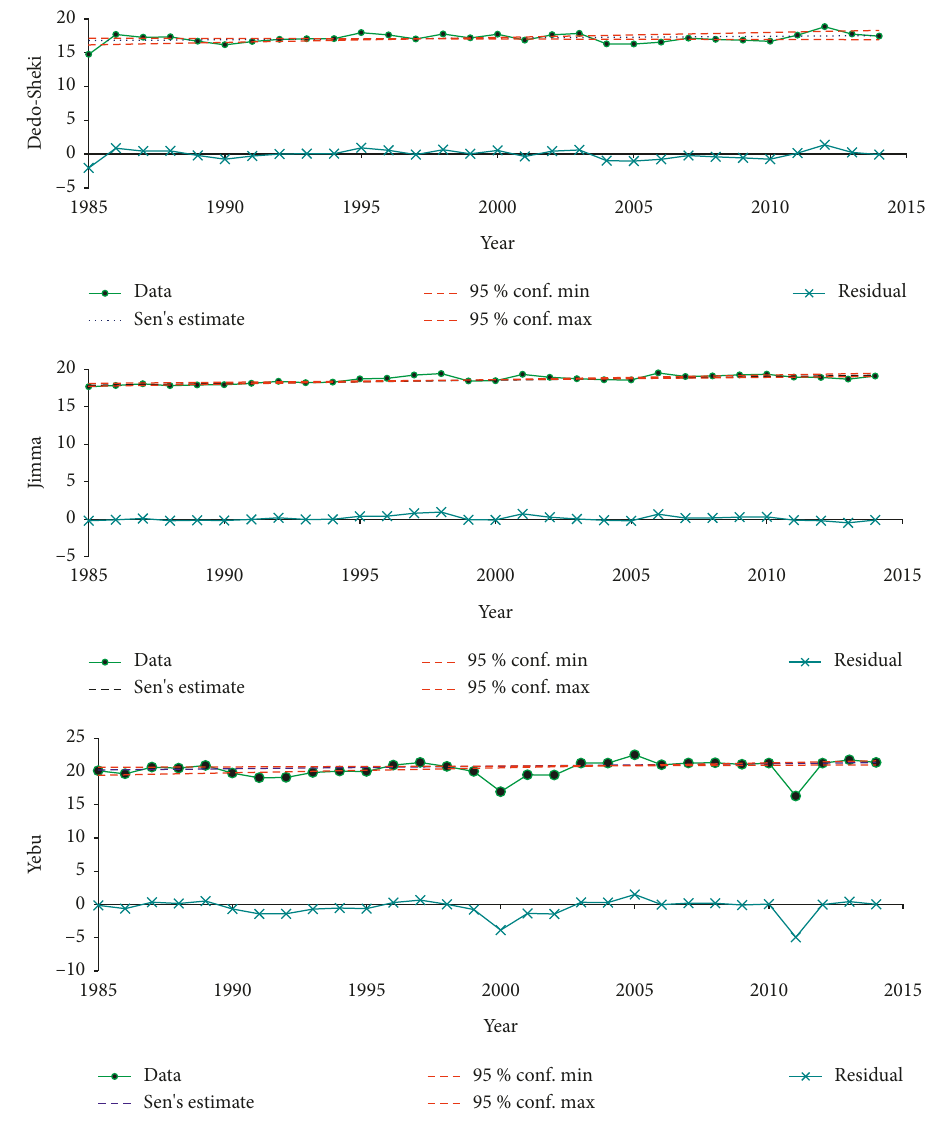
Figure 5: Trends for temperature data at three stations in Gilgel Gibe river catchment.